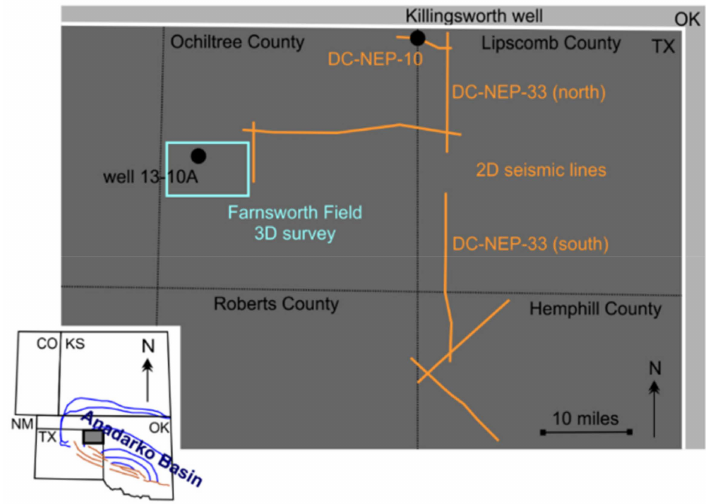
Figure 2. Overview map of Farnsworth Field study site within Ochiltree County, seismic lines and well data used in this study, and locations of 2D seismic lines and 3D seismic survey. The inset shows the location (grey) of the map. The Killingsworth well has been used for the well-tie with DC-NEP-10. Well 13-10A is a CO 2 injection well in Farnsworth